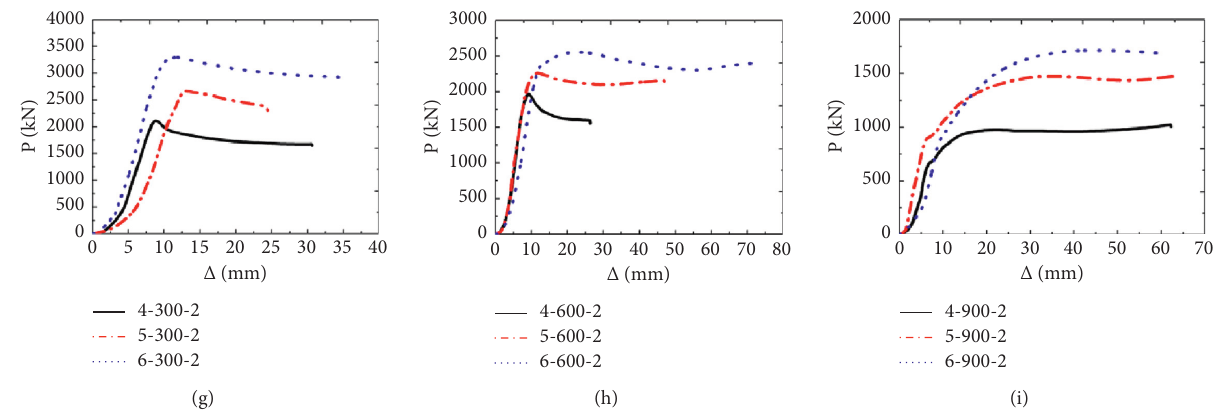
Figure 16: Different wall thicknesses for the same heating duration and temperature. (a) 300 ° C temperature with 1 hour heating. (b) 600 ° C temperature with 1 hour heating. (c) 900 ° C temperature with 1 hour heating. (d) 300 ° C temperature with 1.5 hours heating. (e) 600 ° C temperature with 1.5 hours heating. (f) 900 ° C temperature with 1.5 hours heating. (g) 300 ° C temperature with 2 hours heating. (h) 600 ° C temperature with 2 hours heating. (i) 900 ° C temperature with 2 hours